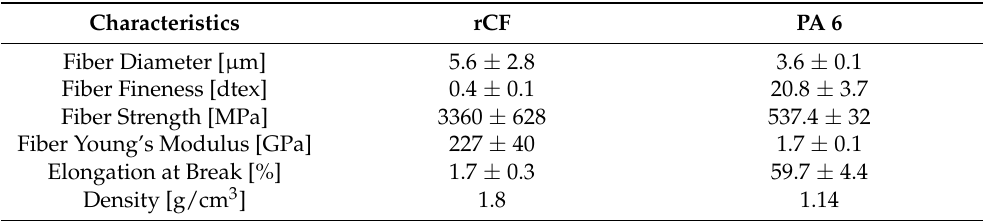
Table 1. Filament properties.